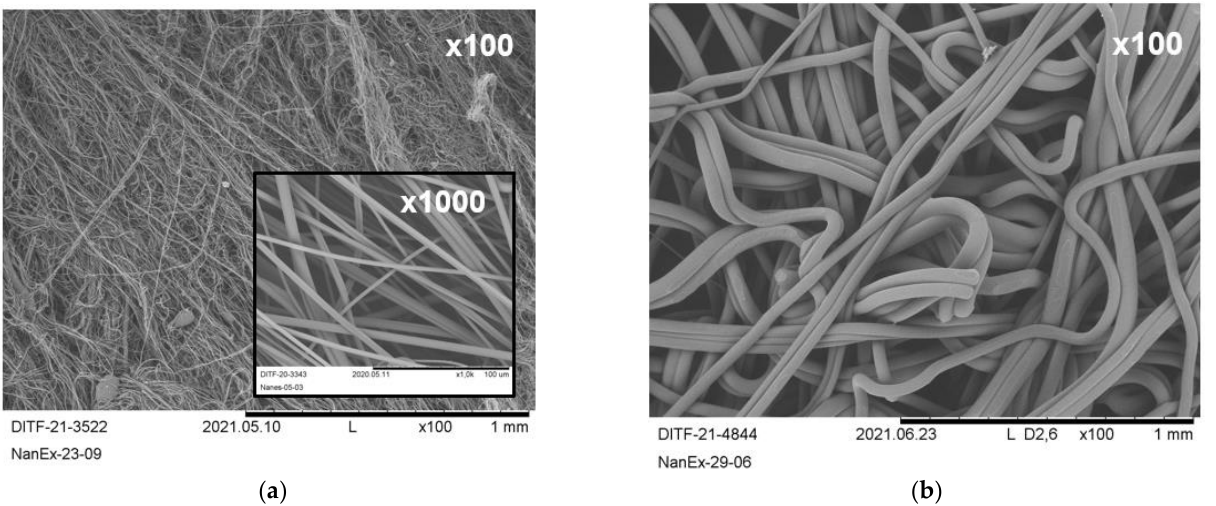
Figure 7. REM-images (×100 and ×1000) of PP fabrics with: ( a ) minimal median fiber diameter (0.8 μm); ( b ) maximal median fiber diameter (39.3 μm).